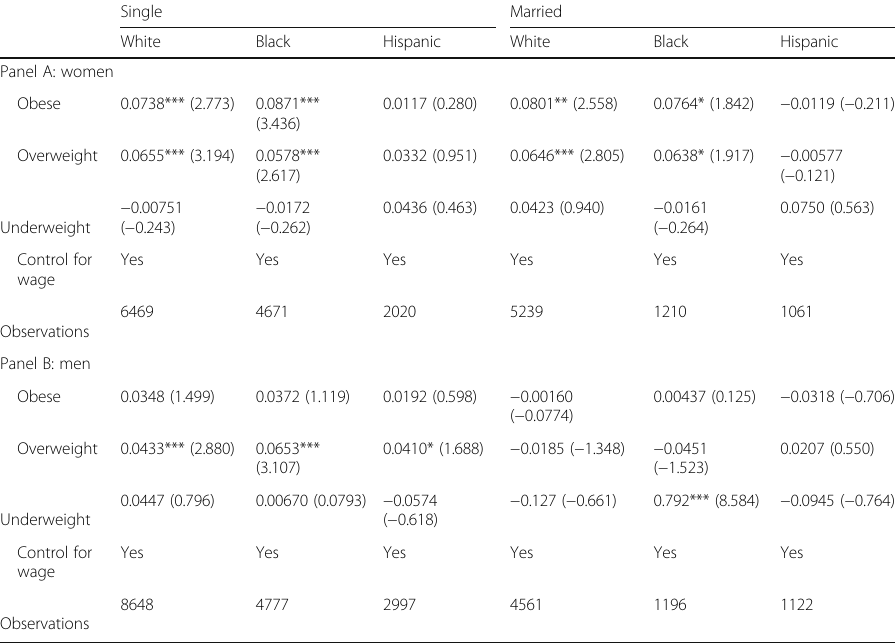
Table 12 Clinical weight categories and log hours of work: OLS results for men and women with sibling Single Married White Black Hispanic White Black Hispanic Panel A: women